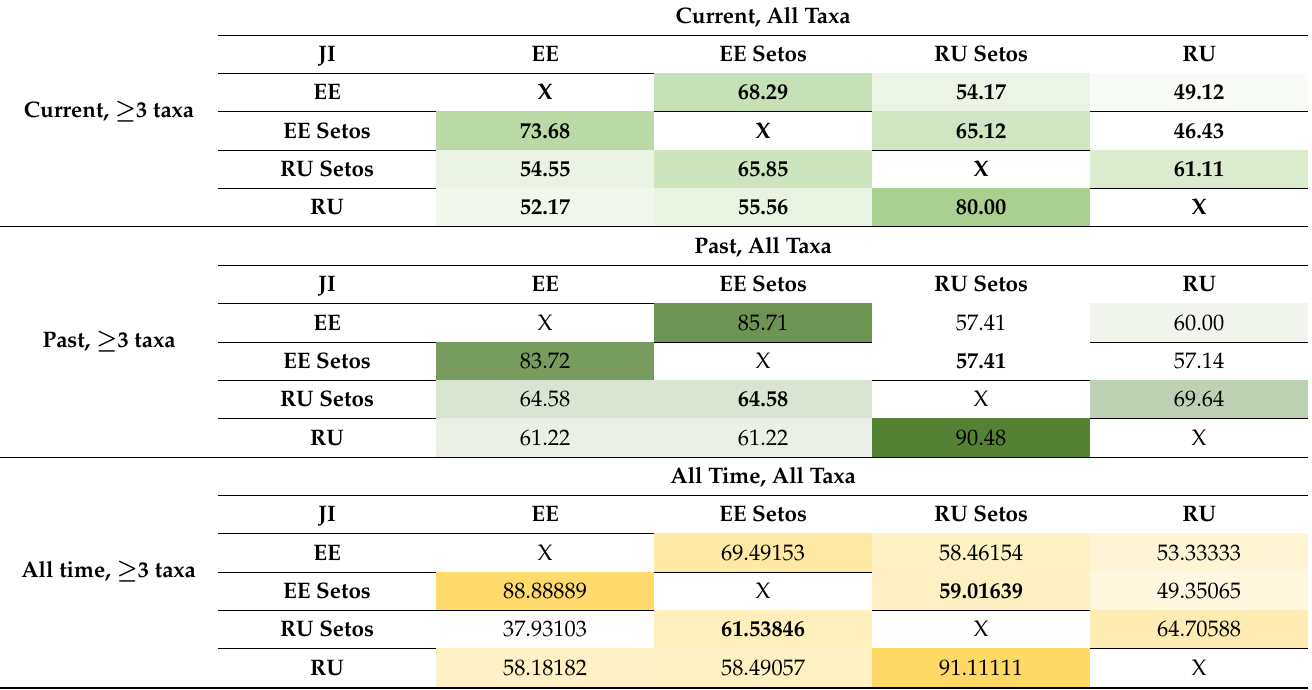
Table 5. Jaccard Similarity Index (JI) calculated for taxa used by Estonians (EE), Estonian Setos (EE Setos), Russian Setos (RU Setos) and Russians (RU)–Current uses–Past uses–All uses. Right top of each table: all taxa. Left bottom of each table: taxa recorded three or more times.